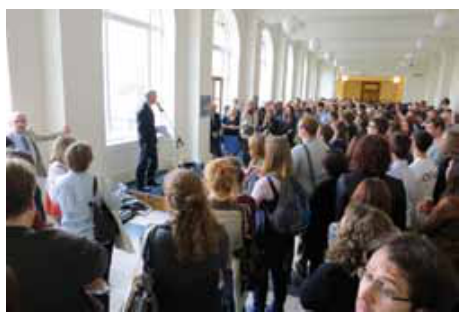
Fig. 3: Staff and students, past and present, gather in UCL to celebrate 75 years of the Institute of Archaeology.